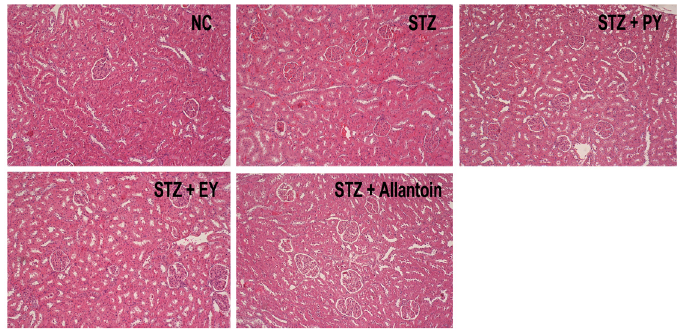
Figure 8. Microphotographs of renal tissues (H ‐ E staining, 100×). NC, normal control; STZ, diabetic control; STZ + PY, crude yam powder ‐ treated diabetic; STZ + EY, water extract of yam ‐ treated diabetic; STZ + Allantoin, allatoin ‐ treated diabetic rats.